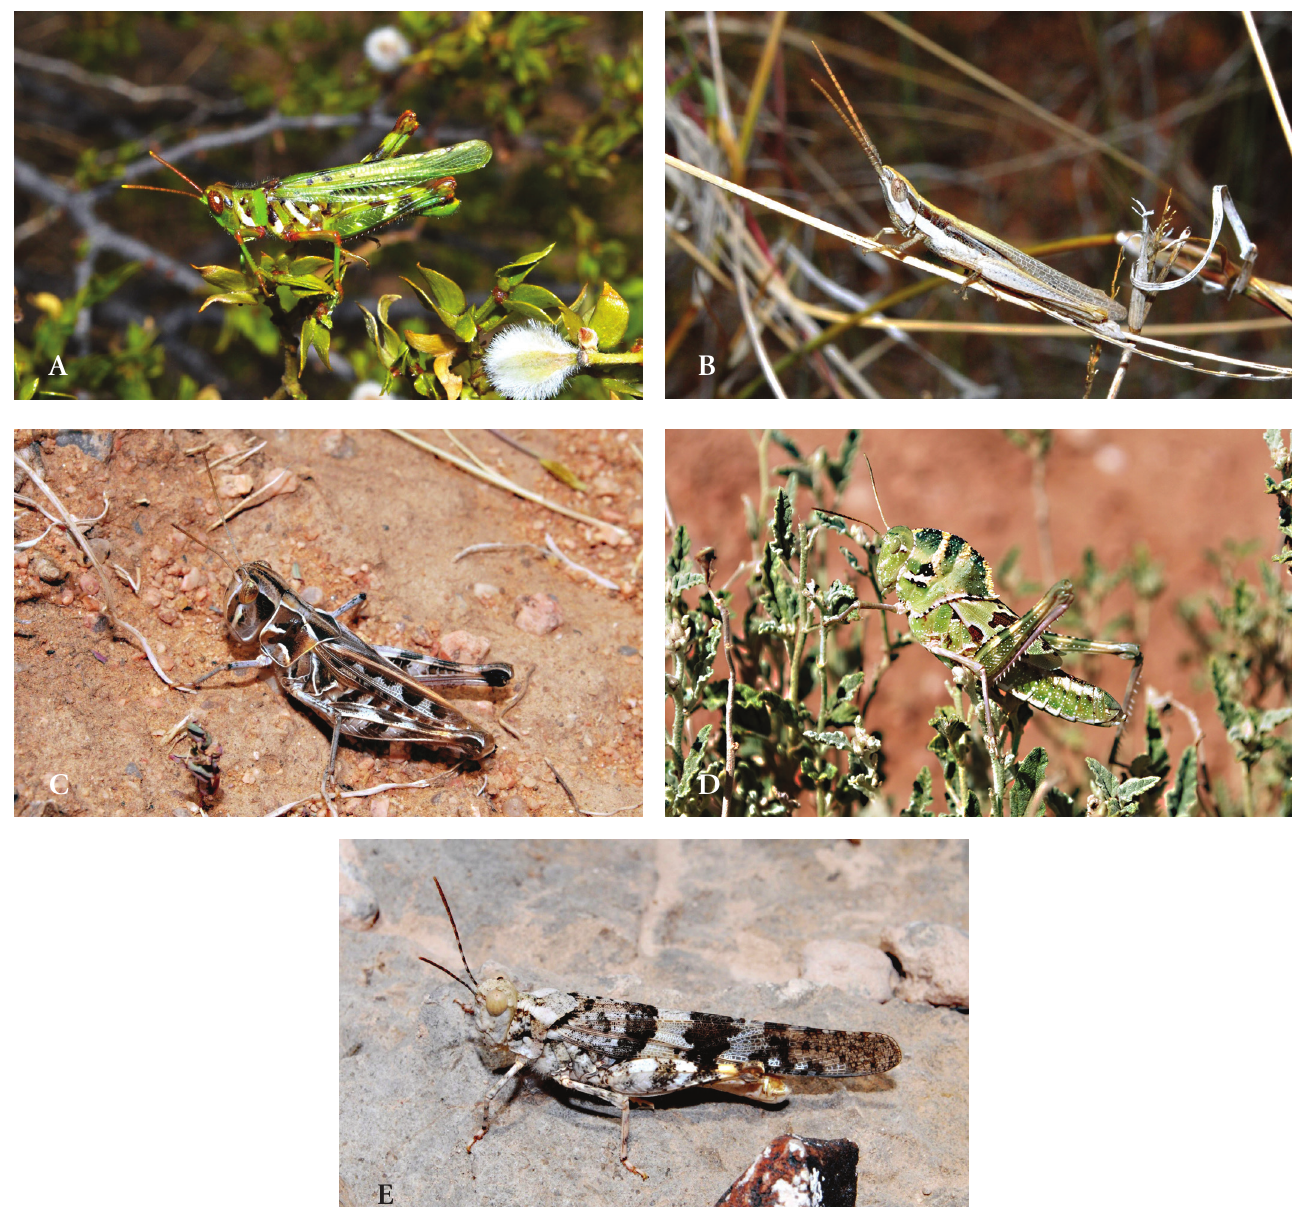
Fig. 4. Examples of each grasshopper life-form type; A. Arbusticole; Bootettix argentatus on Larrea tridentata ; B. Graminicole; Paropomala pallida on Bouteloua eriopoda ; C. Terri-graminicole; Phlibostroma quadrimaculatum ; D. Herbicole; Tropidolophus formosus on Spharalcea hastulata ; E. Terricole; Trimerotropis pallidipennis